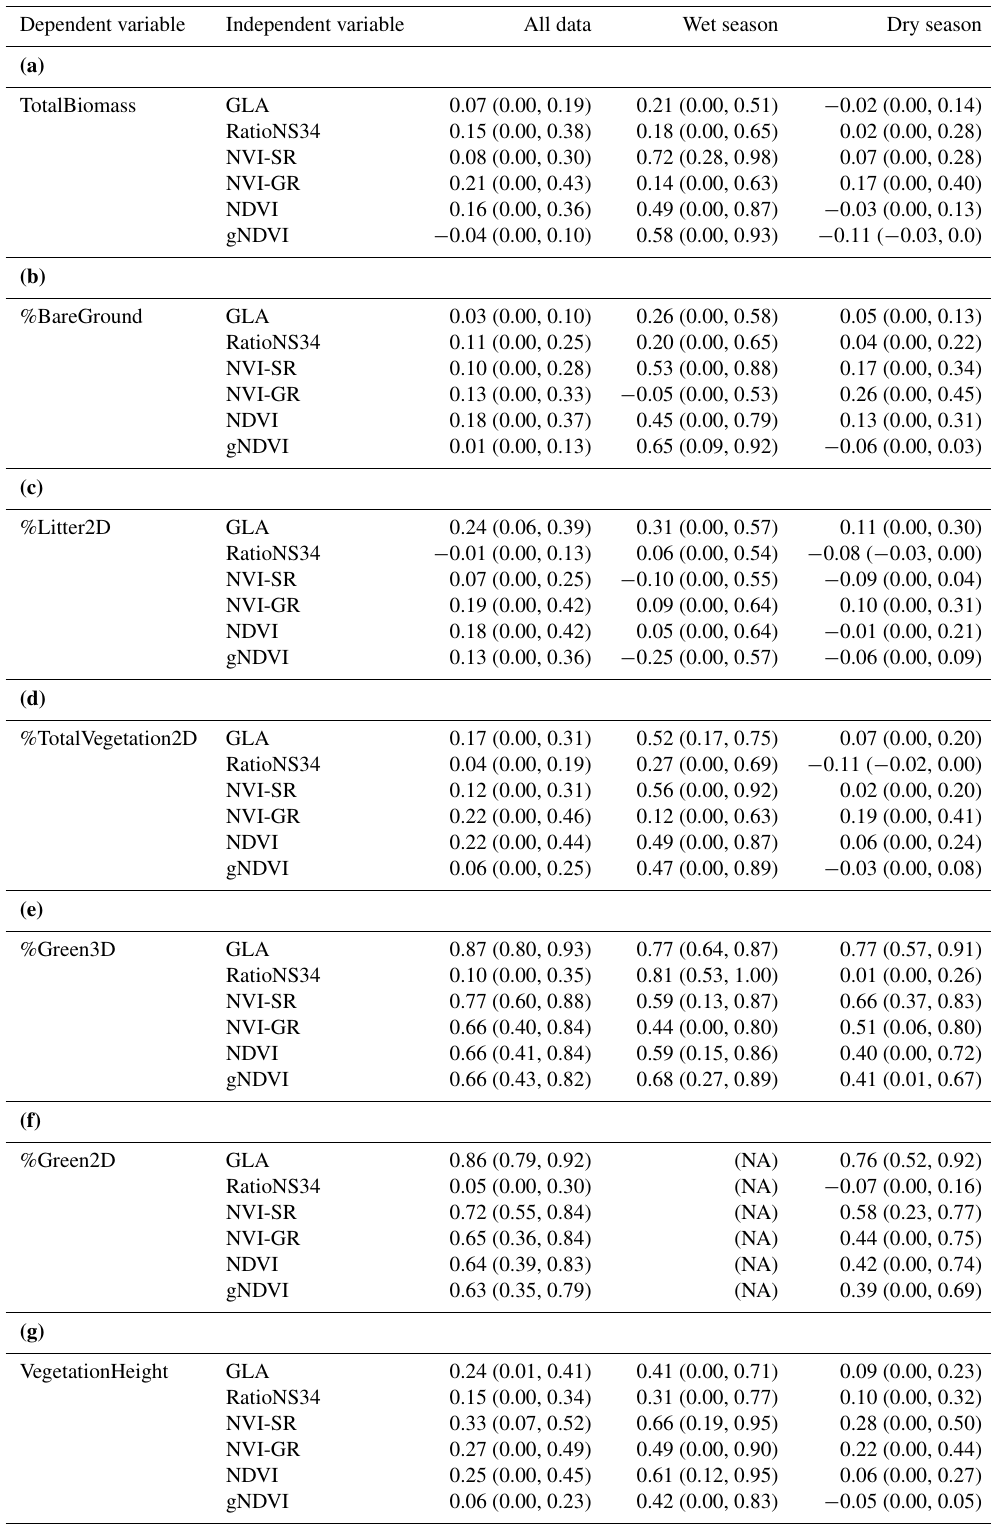
Table 4. Bias-adjusted bootstrap point estimates of R 2 (in parenthesis, the lower and upper bound of the corresponding 95% pivotal bootstrap confidence intervals) for all GAM combinations of sensor-derived indices. (a) TotalBiomass, (b) %BareGround, (c) %Litter2D, (d) %TotalVegetation2D, (e) %Green3D, (f) %Green2D, and (g) VegetationHeight. See Fig. 8 for graphs comparing these results. NA = not